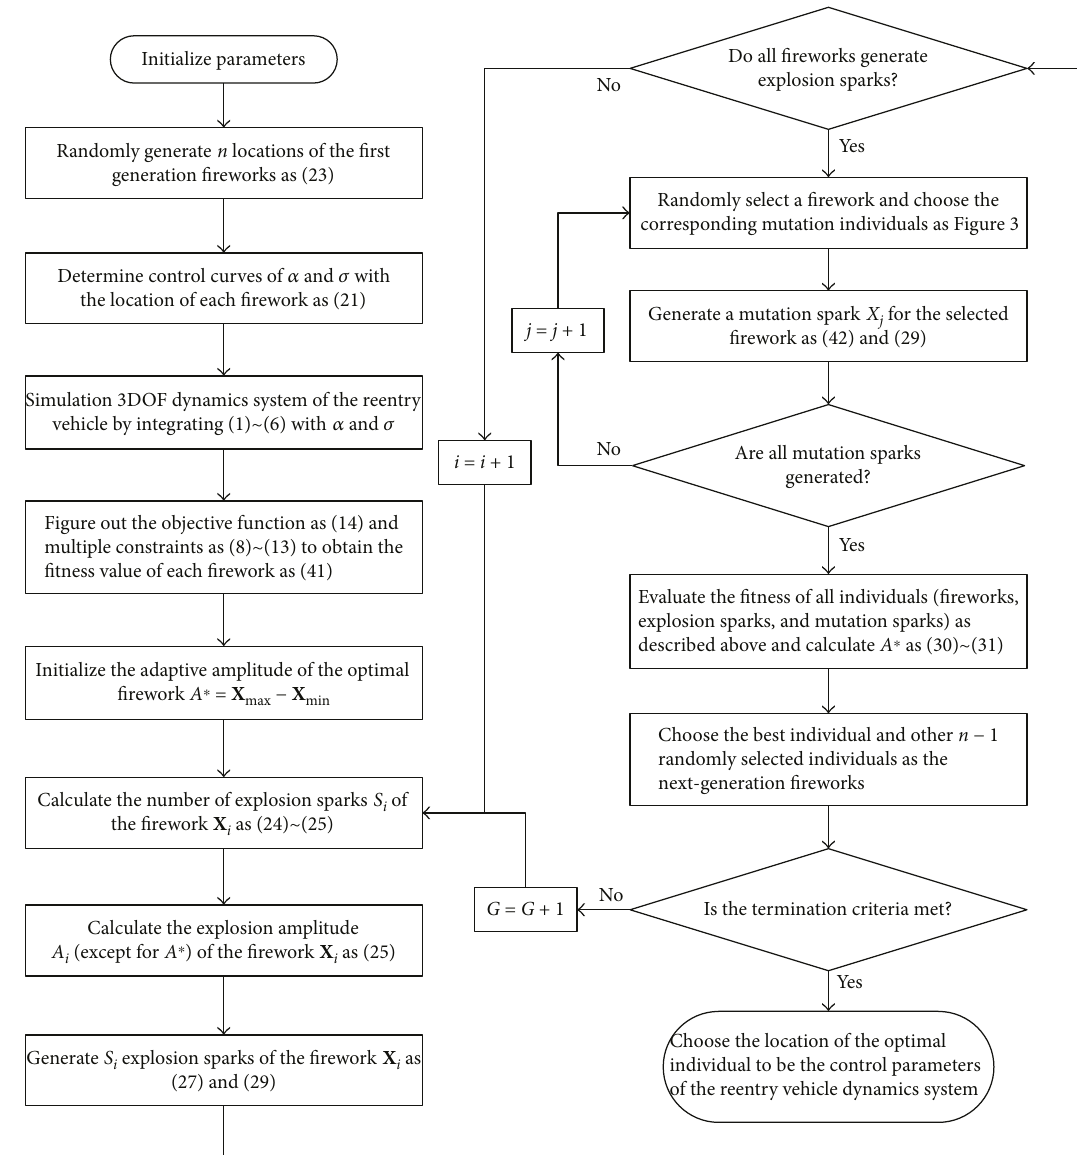
Figure 4: Reentry trajectory optimization based on the I-AFWA with a new mutation strategy.